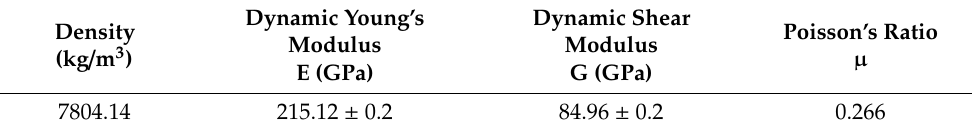
Figure 3. Schematic diagram of ultrasonic fatigue test [2,15]. Table 3. Test results of the dynamic Young’ s modulus, shear modulus, and Poisson’s ratio.